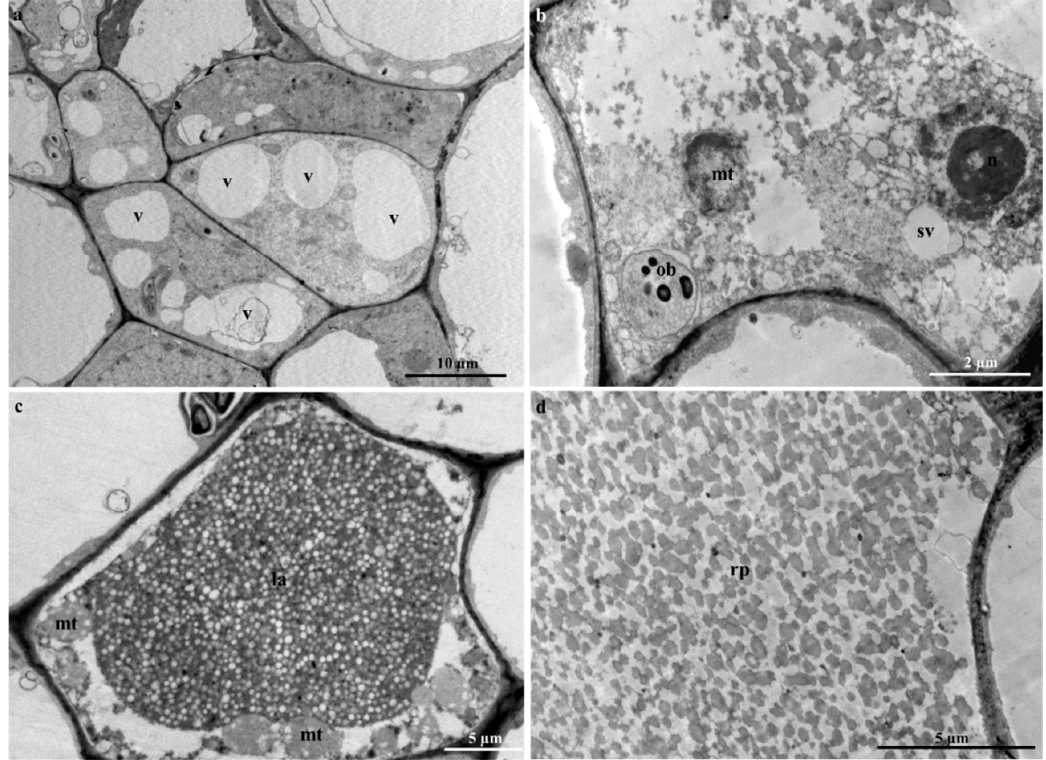
Figure 11. Latex production in adult leaves of T. ventricosa . ( a ) Highly vacuolated cytoplasm of young laticifer. ( b ) Initiation of secretory activity. ( c ) Latex metabolites forming an emulsion within the central vacuole of the laticifer cell. ( d ) Rubber particles within the latex emulsion. Abbreviations: v = vacuole, ob = osmiophilic bodies, mt = mitochondria, n = nucleus, sv = small vacuole, la = latex, rp = rubber particle.